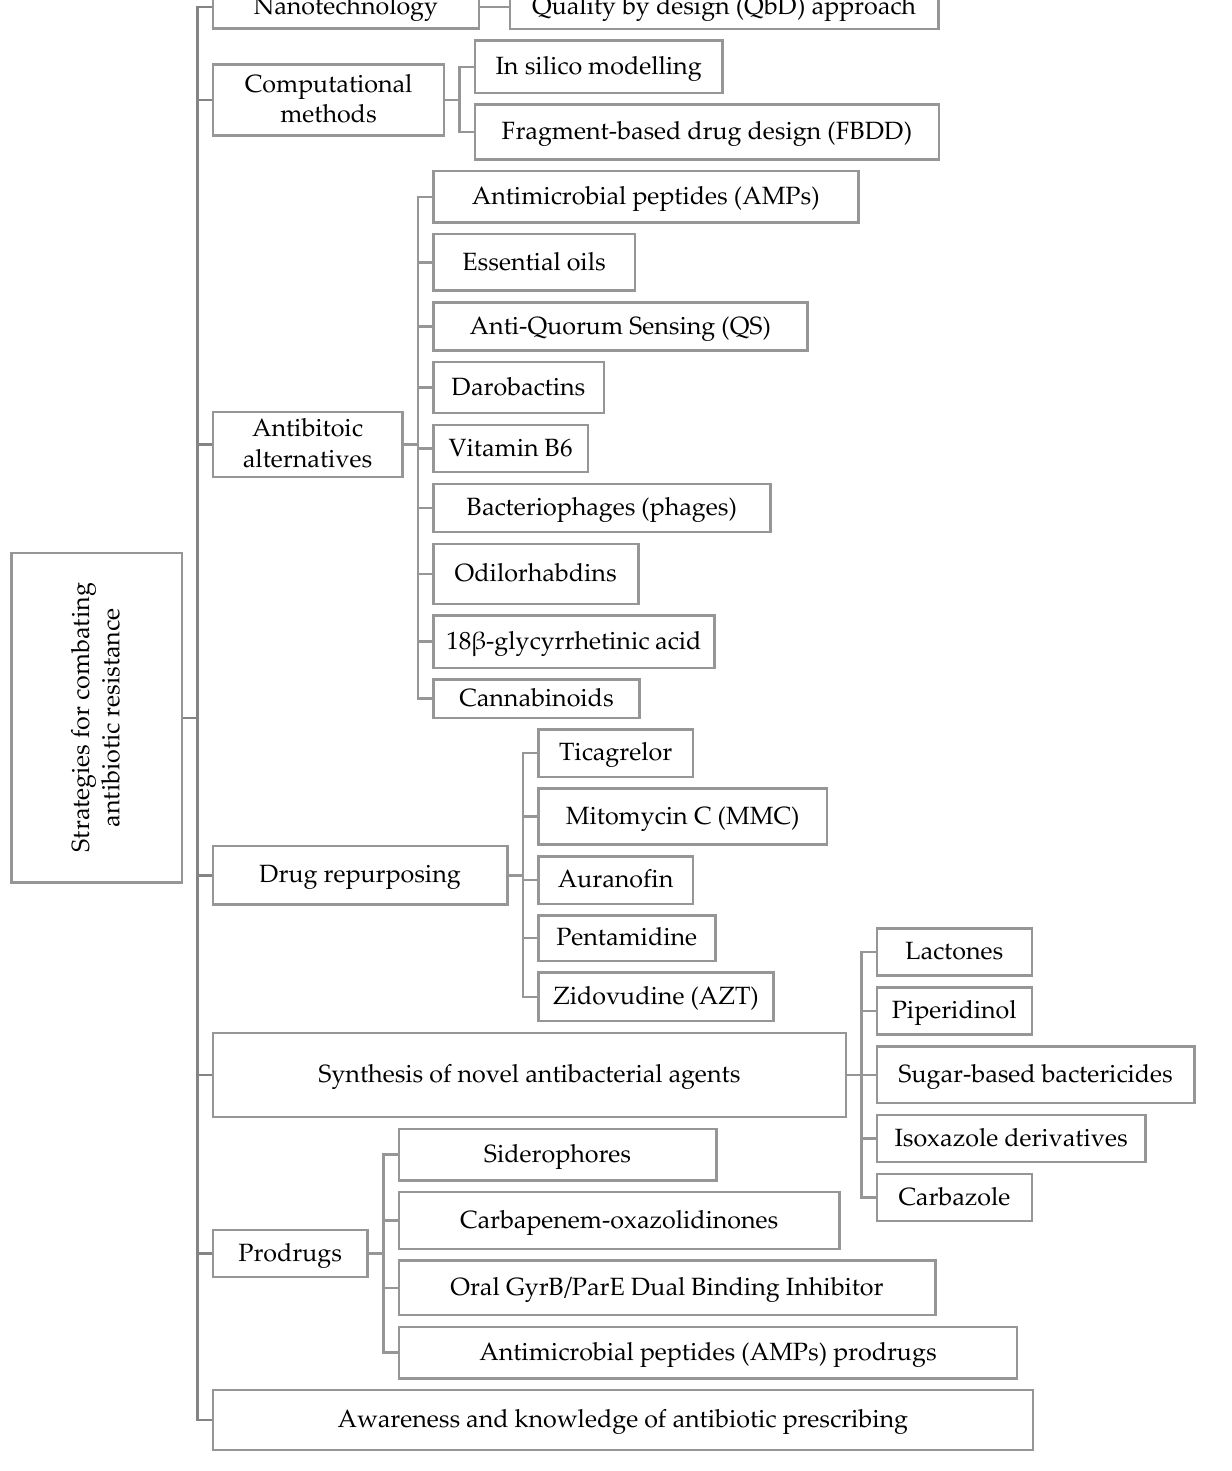
Figure 8. Strategies for combating antibiotic resistance including, nanotechnology, computational methods, antibiotic alternatives, drug repurposing, synthesis of novel antibacterial agents, prodrugs, awareness, and knowledge of antibiotic prescribing.